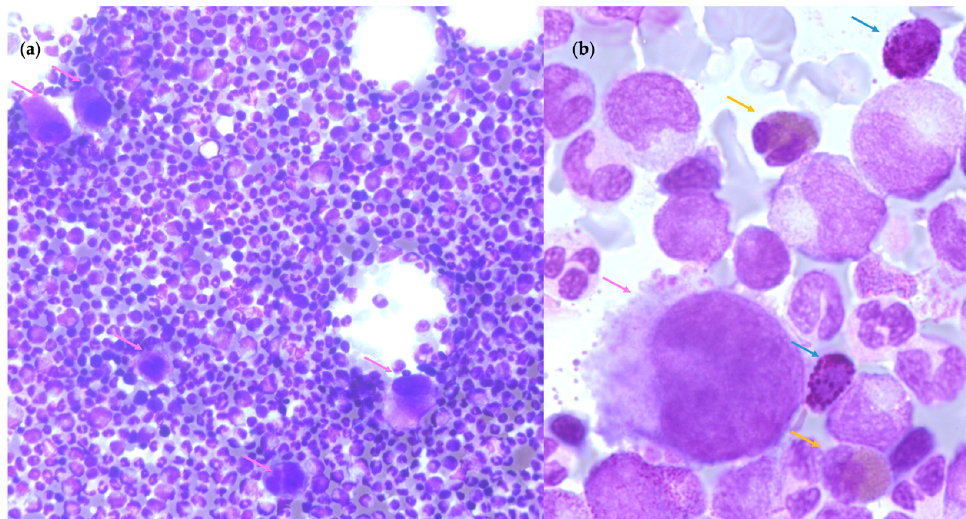
Figure 7. Bone marrow cellularity and morphological aspects of megakaryocytes in Chronic Myeloid Leukemia. ( a ) Granulocytic hyperplasia and small MKs (pink arrows) (optical microscopy, May Grünwald Giemsa (MGG), ×20 magni fi cation) ( b ) A small MK and eosinophil (yellow arrows) and basophil (blue arrows) cells (optical microscopy, May Grünwald Giemsa (MGG), ×50 magni fi cation).